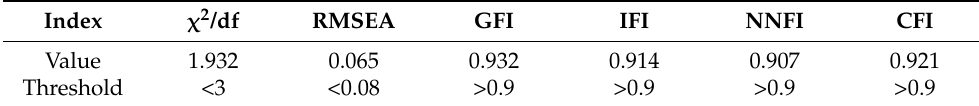
Table 3. Results of model fitting